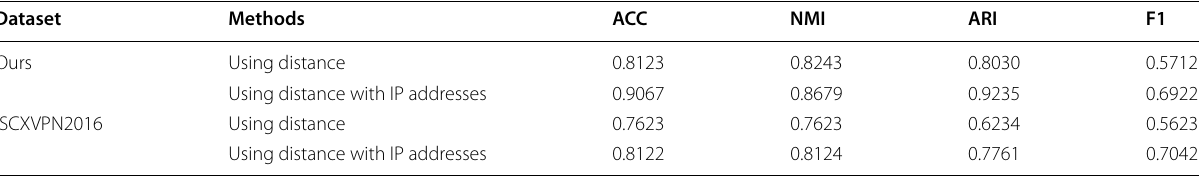
Table 6 Ablation study on the methods of constructing the graph